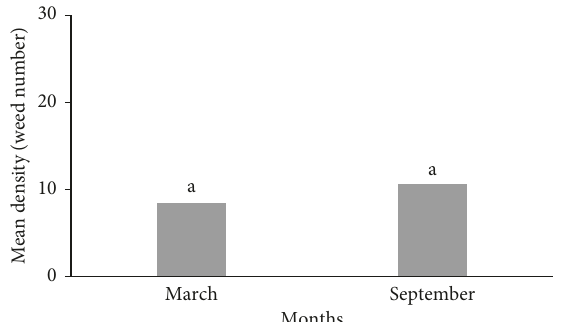
Figure 6: Mean density of parthenium weed during two surveys in March and September 2015. The results are the means of all villages. Similar small letters on bars indicate a nonsignificant difference.